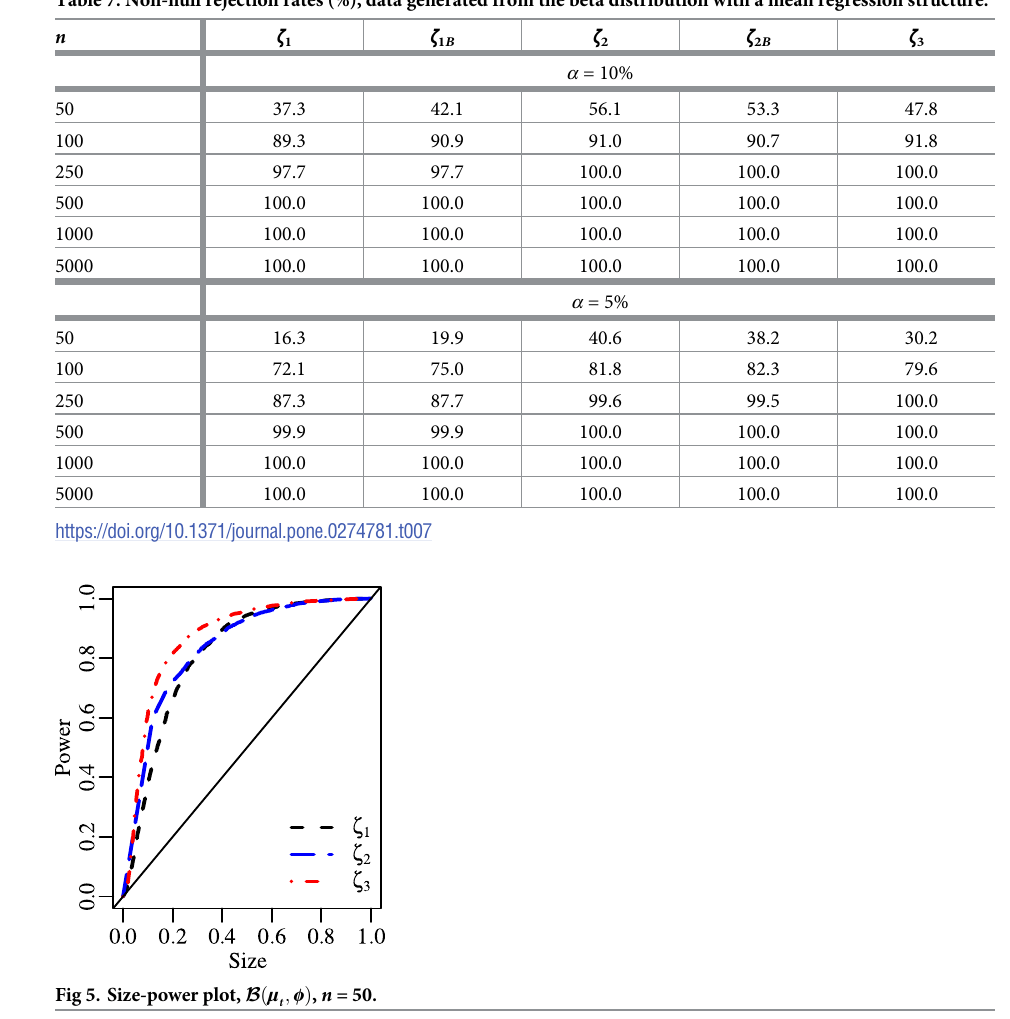
Table 7. Non-null rejection rates (%), data generated from the beta distribution with a mean regression structure.